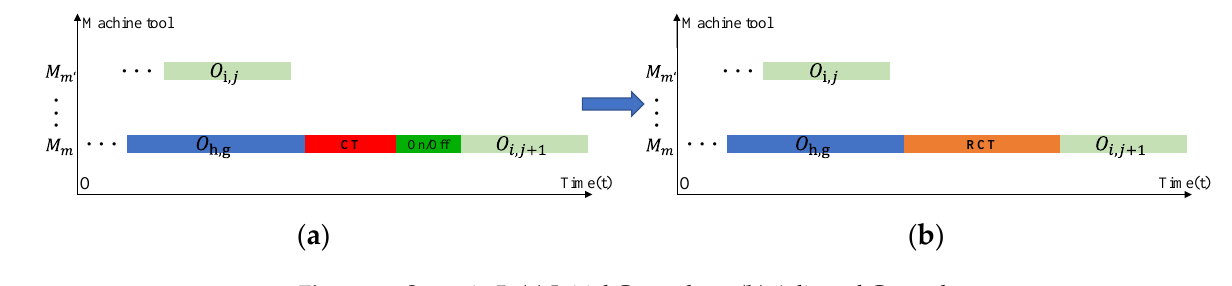
( b ) Figure 9. Scenario 3: ( a ) Initial Gantt chart; ( b ) Adjusted Gantt chart.